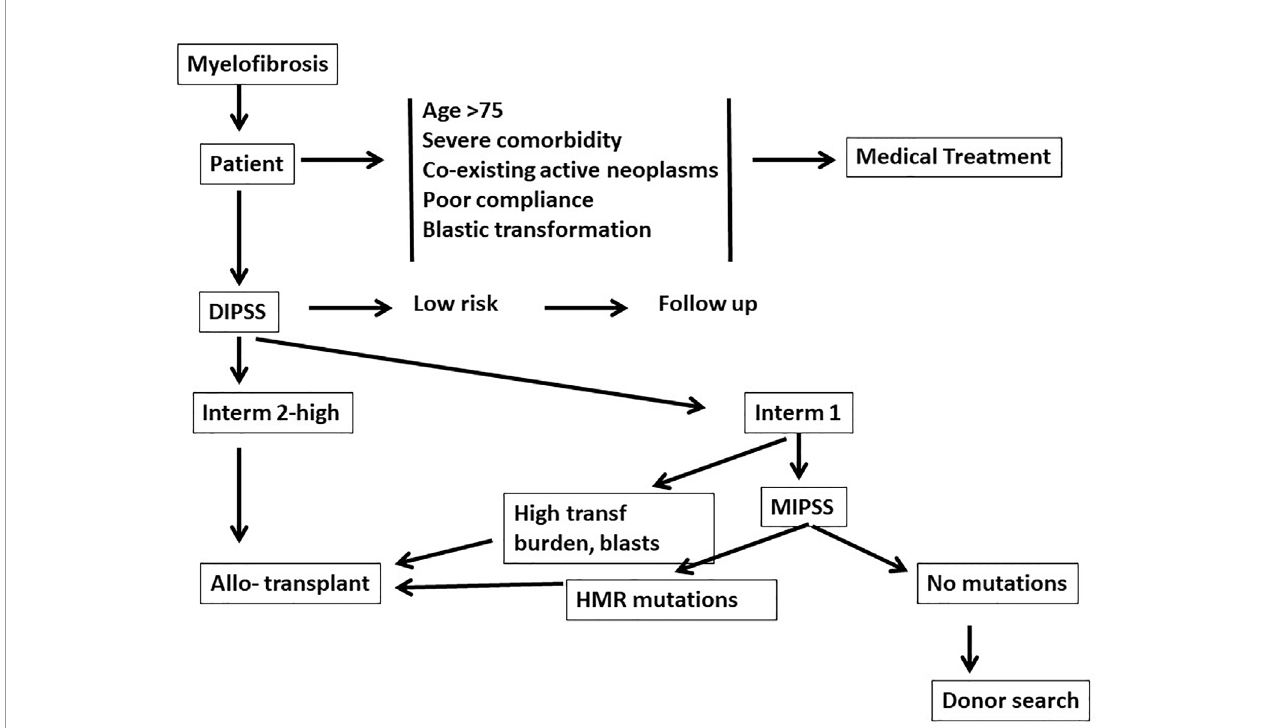
FIGURE 1 | Eligibility for a transplant procedure in patients with myelo fi brosis: medical treatment should be offered for older patients (>75 years) and/or patients with comorbidities. Dynamic international prognostic scoring system (DIPSS) will then identify patients low risk patients, who should be followed. DIPSS-intermediate 2 and high risk patients are who are strong candidates for an allogeneic transplant. DIPSS-Intermediate 1 patients with a high transfusion burden and blasts counts are also strong candidates for an allogeneic transplant. Patients may also be studied with a molecular international prognostic scoring system (MIPSS), and may be eligible for transplantation if high risk mutations (HMR) (see text) are identi fi